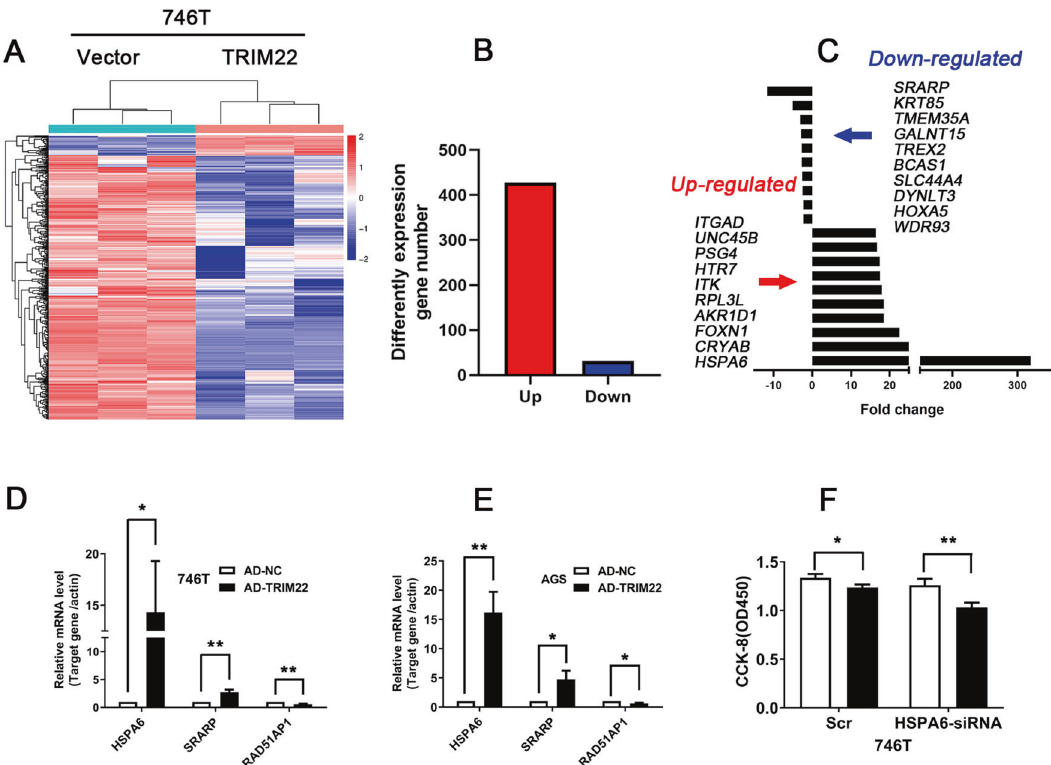
Fig. 3 The effect of TRIM22 overexpression on gene expression in gastric cancer cells. A Thermogram of differentially expressed genes caused by TRIM22 overexpression. The analysis was performed by RNA-Seq. B , C Statistical analysis of differential gene mRNA expression.